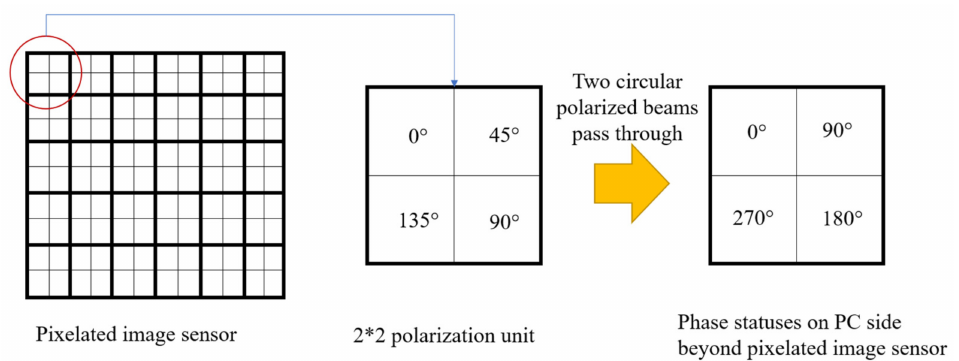
Figure 2. Illustration of the polarisation directions for the micro-polarisation image sensor applied and the corresponding phase